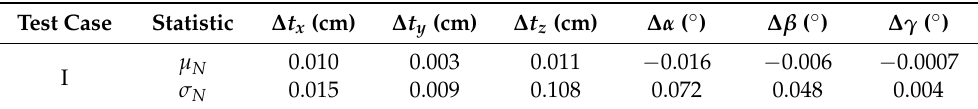
Table 14. Mean and standard deviation of the pose estimation errors for a higher uncertainty in the knowledge of the initial condition, for test case I.